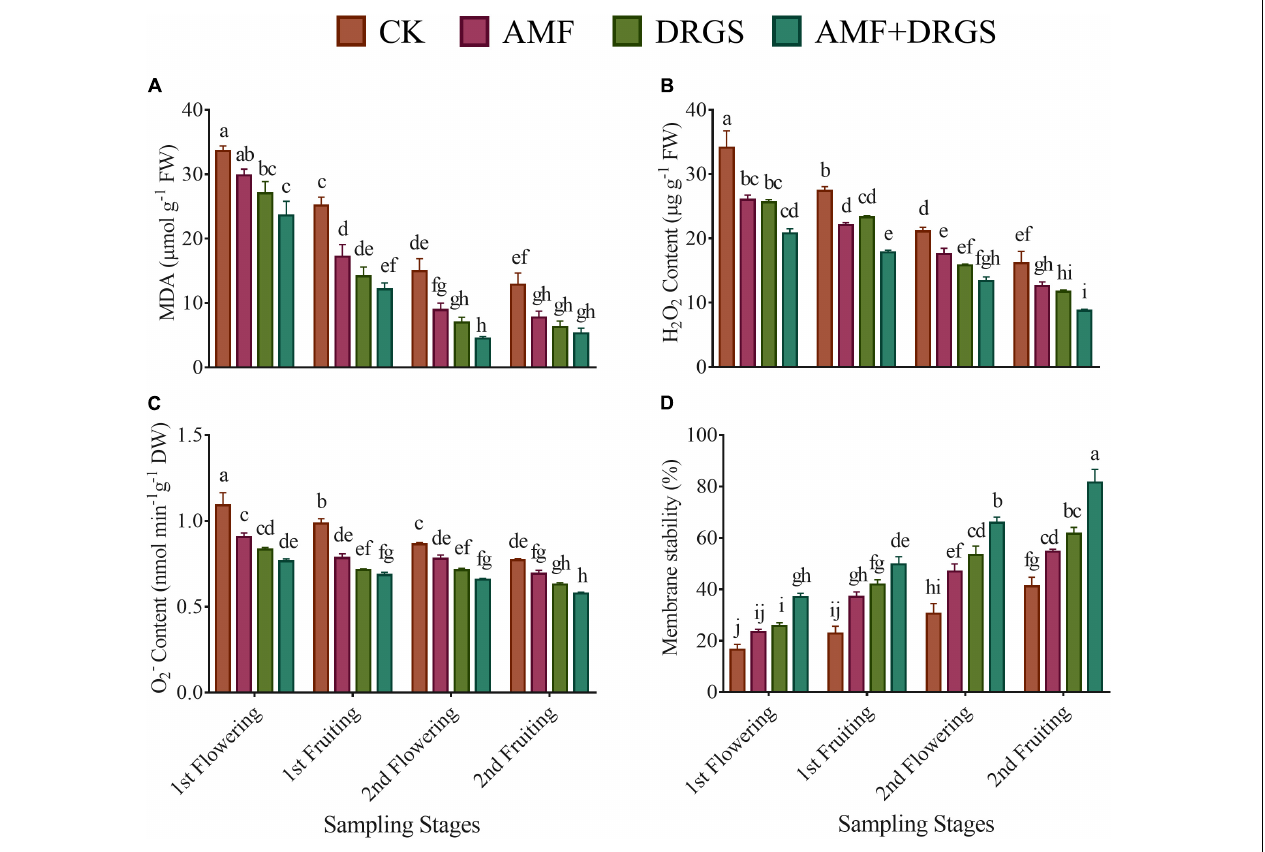
FIGURE 6 | Effect of AMF inoculation and amendment with dry raw garlic stalk on (MDA) malondialdehyde (A) , hydrogen peroxide (B) , superoxide (C) , and membrane stability index (D) on eggplant leaves at 1st flowering, 1st fruiting, 2nd flowering, and 2nd fruiting stages. Data represent the mean of ± SE ( n = 5). Different letters show significant differences within treatments. Tukey’s HSD test was employed to verify statistical significance at p < 0.05.